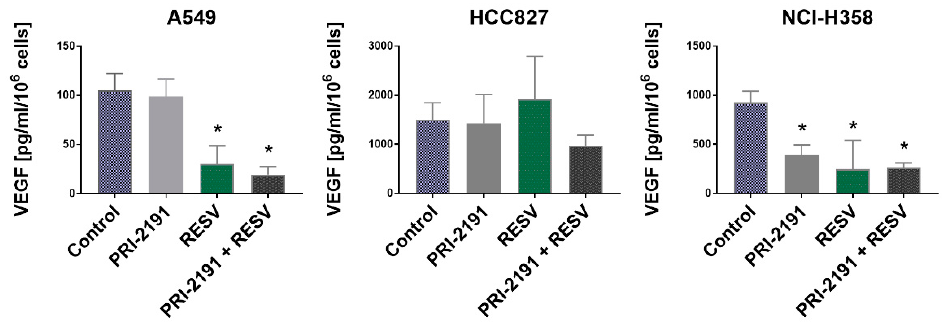
Figure 6. Effect of PRI-2191 and RESV on vascular endothelial growth factor (VEGF) secretion by lung cancer cells. RESV was used at a concentration of 20 µM and PRI-2191 at 100 nM. Cells were exposed to tested compounds for 72 h, then washed with PBS, and cultured in a serum-free me- dium for the next 24 h. Conditioned medium was collected, and the level of VEGF secreted by lung cancer cells was measured by ELISA. A549: * compared to control (untreated cells) and PRI- 2191; NCI-H358: * compared to control ( p < 0.05, one-way ANOVA with Tukey’s post hoc with multiple comparisons).